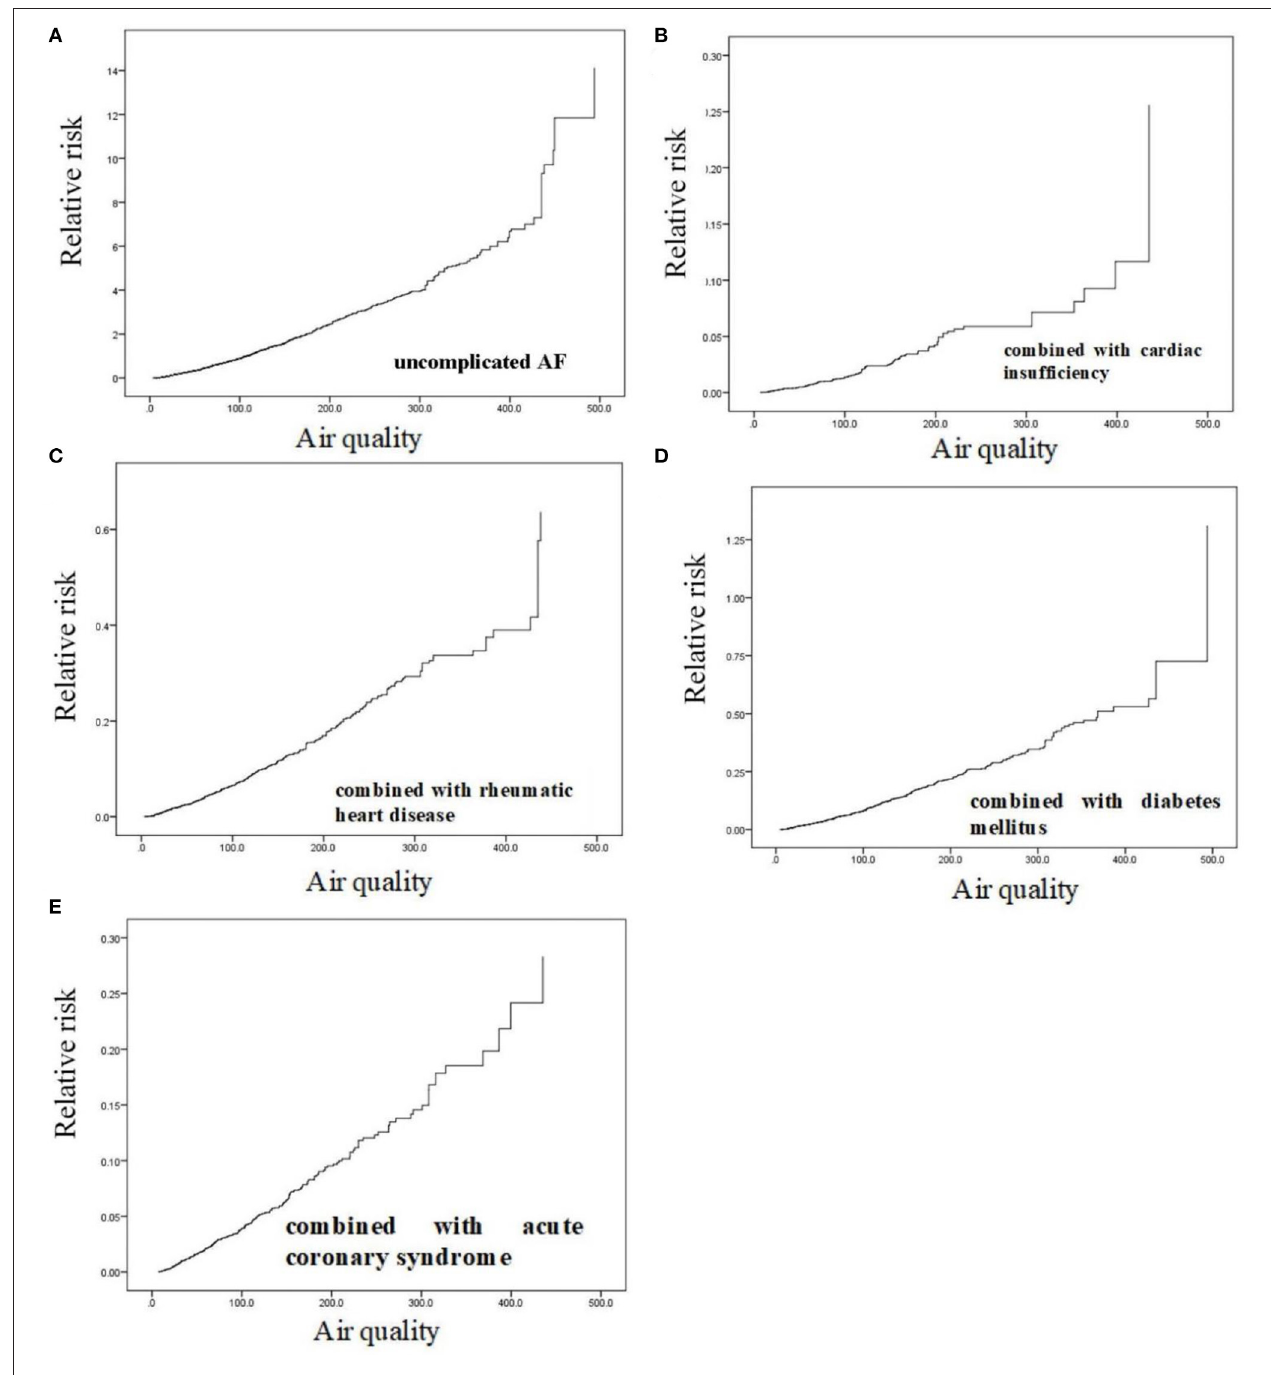
FIGURE 3 | Correlation analysis of particulate matter with aerodynamic diameter < 2.5 µ m and risk of emergency room visits for patients with atrial fibrillation. (A) uncomplicated AF; (B) AF combined with cardiac insufficiency; (C) AF combined with rheumatic heart disease; (D) AF combined with diabetes mellitus; (E) AF combined with acute coronary